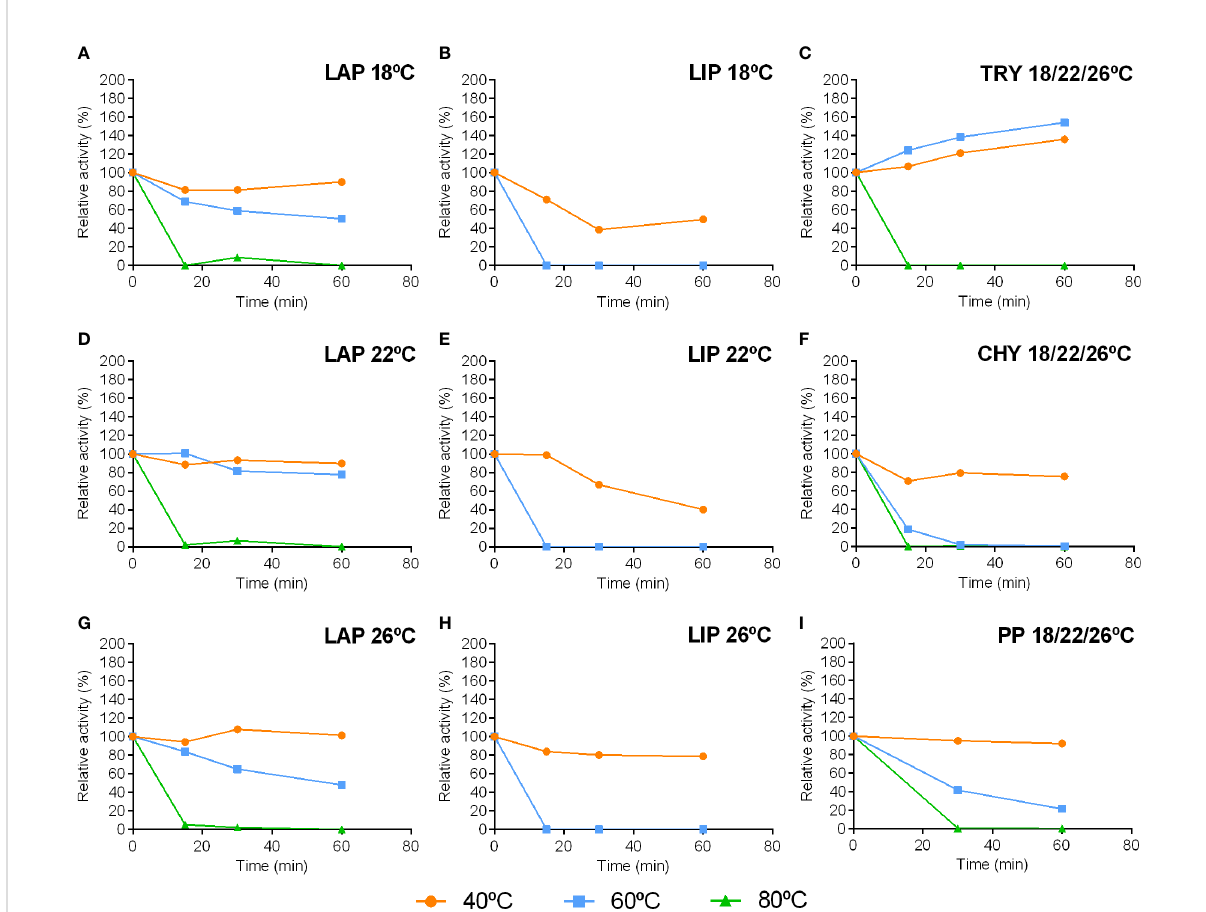
FIGURE 5 Stability of leucine aminopeptidase (LAP), lipase (LIP), trypsin (TRY), chymotrypsin (CHY) and pepsin (PP) activities from pyloric caeca and stomach of S. dumerili incubated at different temperatures. Trypsin, chymotrypsin and pepsin graphs represent mean values from all treatments. Individual graphs of thermal stability for each enzyme in extracts coming from the different rearing temperatures are shown in the Supplementary Figure